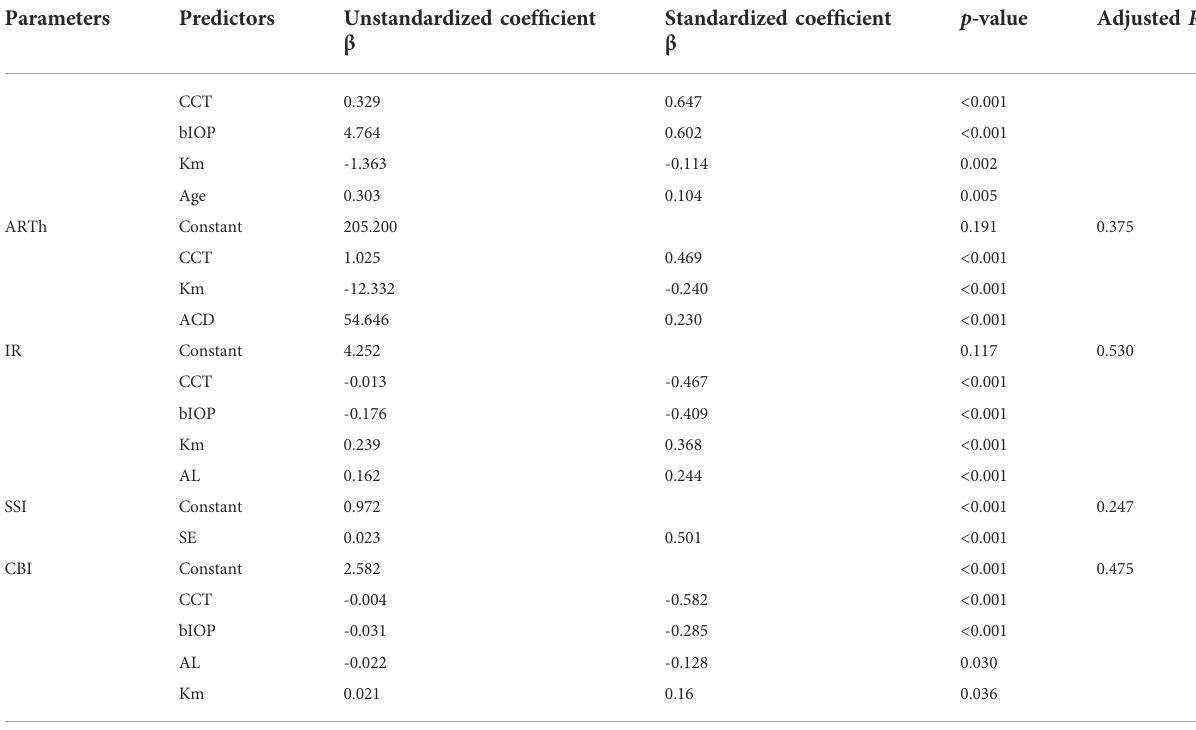
TABLE 2 ( Continued ) Multiple regression analysis for variables predicting corneal biomechanical parameters.